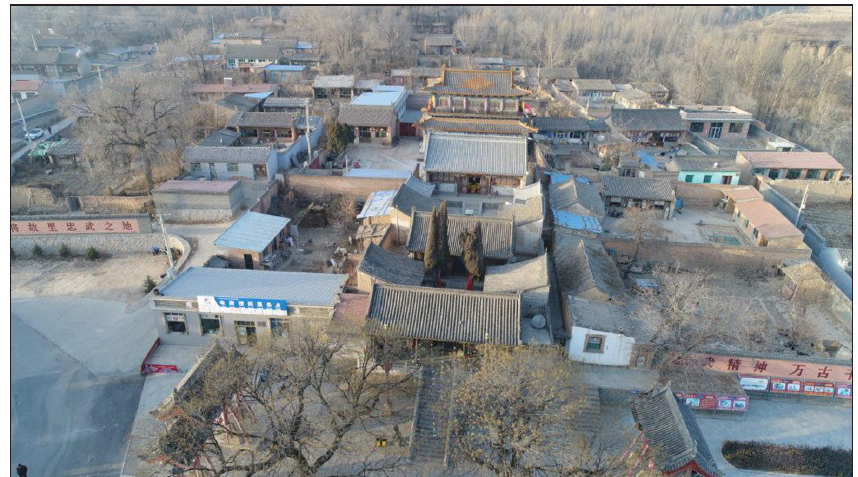
Figure 4: An aerial view of the Yangzhongwu Temple in Lutijian Village, Daixian County. Image courtesy of the SDDP team.